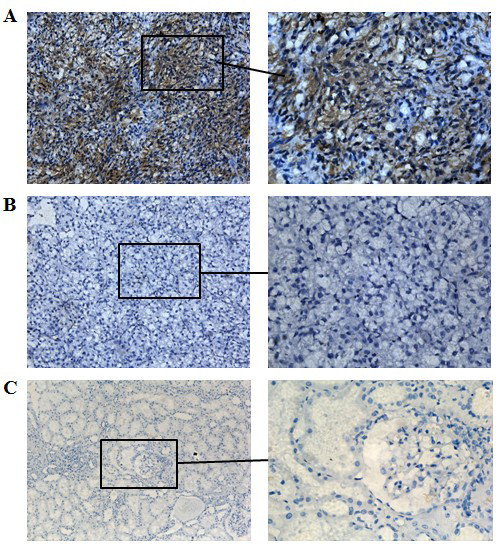
Immunohistochemical staining of PKCε in tissue specimens. PKCε is overexpressed in both cytoplasm and nuclei of clear cell renal cell carcinoma (RCC) cells (A). Primary antibody isotype control (B) and normal renal cells (C) show no or minimal staining. The original magnification was ×200 for left panels and ×400 for right panels.